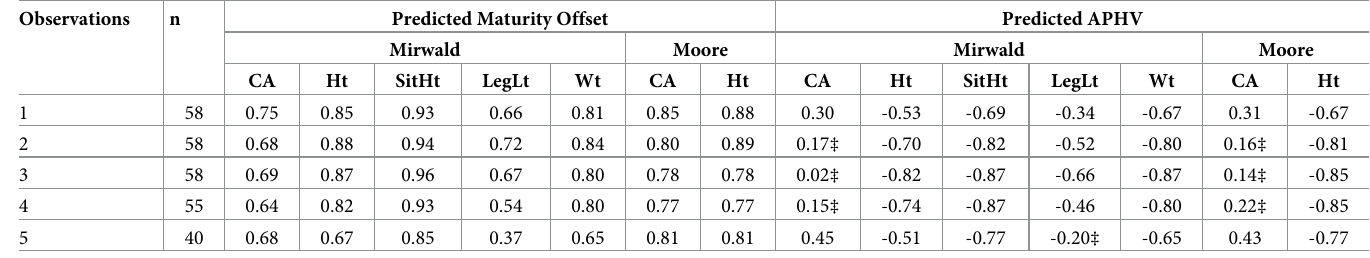
Table 5. Correlations at each observation between predicted maturity offset and predicted APHV (CA–predicted maturity offset) with chronological age (CA), height (Ht), sitting height (SitHt), estimated leg length (LegLt) and body weight (Wt) for the Mirwald equation and with CA and Ht for the Moore equation.